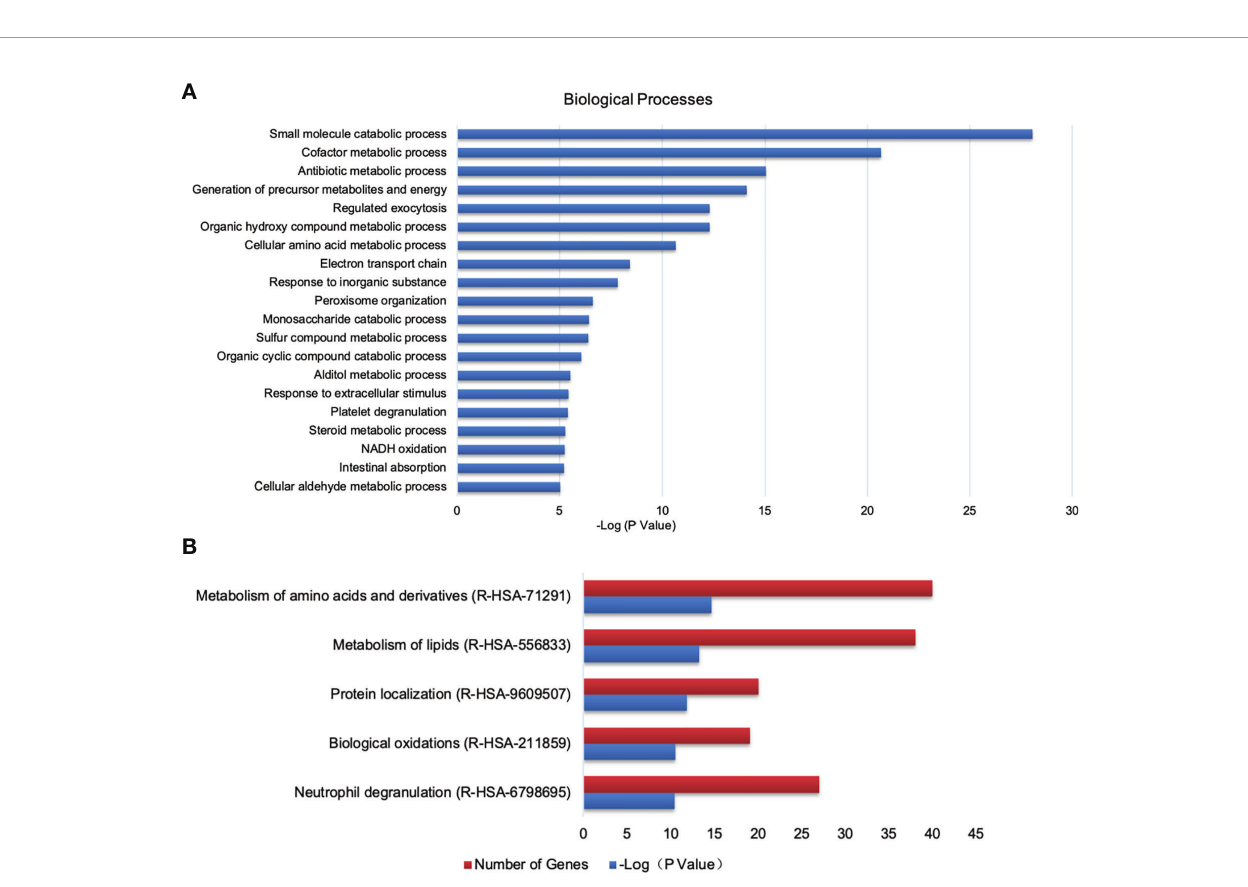
FIGURE 6 | Analysis of DEPs between the control and PEDV group using GO and Reactome database. (A) Biological processes identi fi ed by GO enrichment. (B) The top 5 enriched Reactome